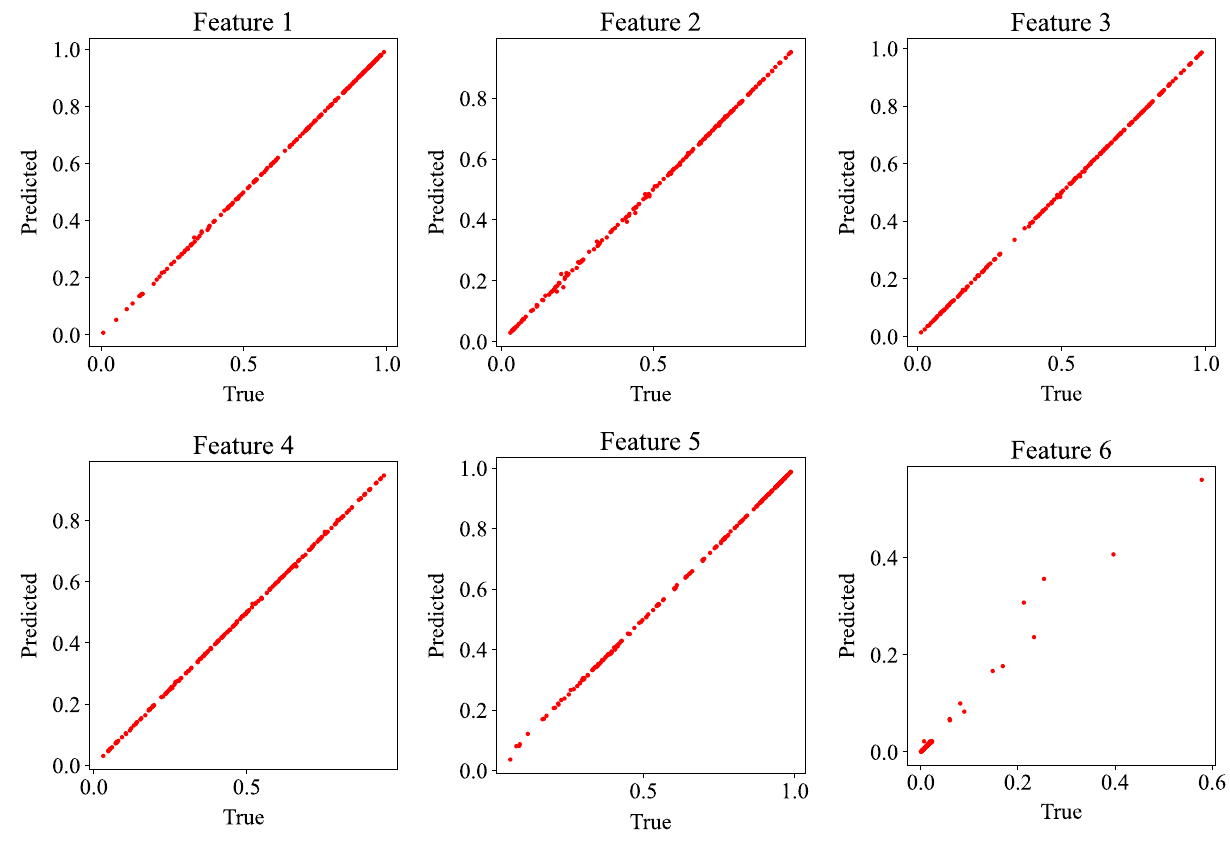
Figure 15. One step ahead prediction results in the latent